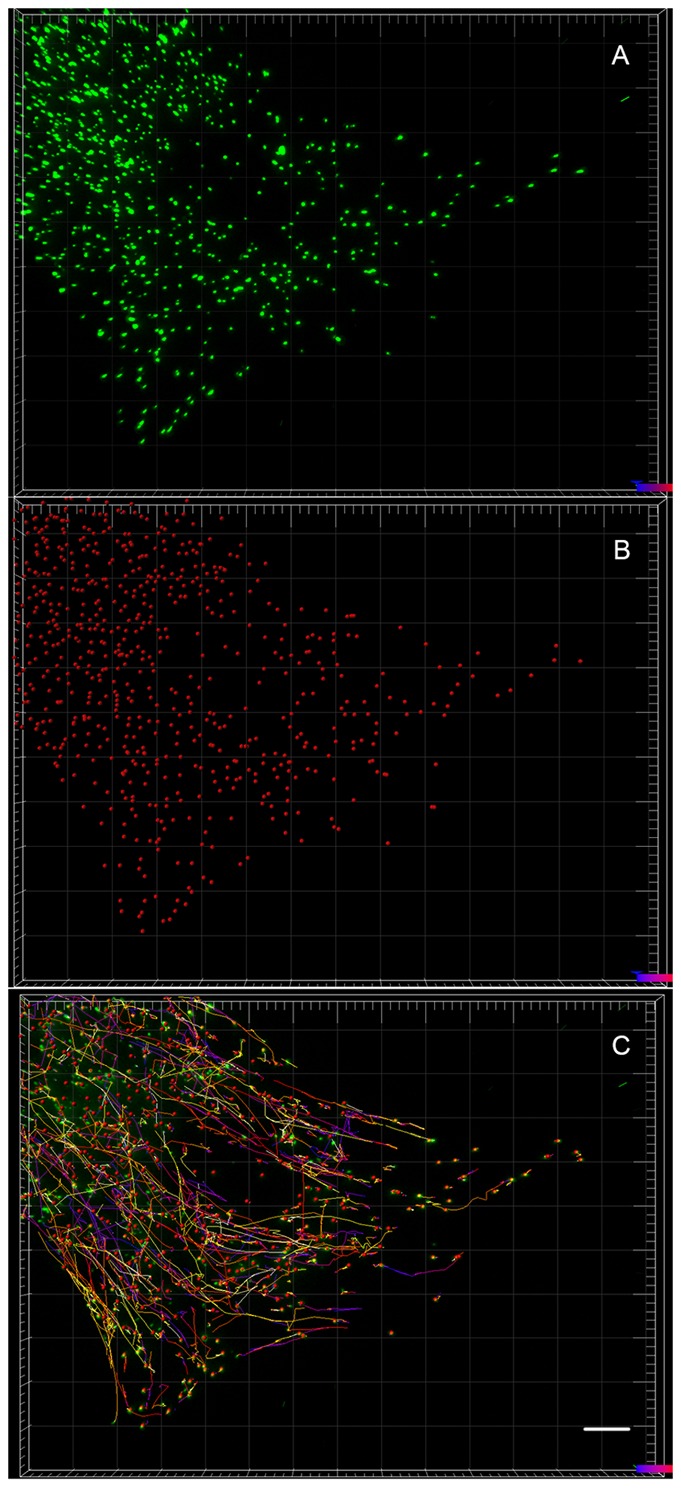
Automated tracking of peroxisomes.(A) Images of the labelled peroxisomes in a cell. (B) The same cell showing the peroxisomes represented as dots after automated identification. (C) The same cell showing the paths taken by all the peroxisomes at the end of the 2 minute observation period. Scale bar: 10 µm.